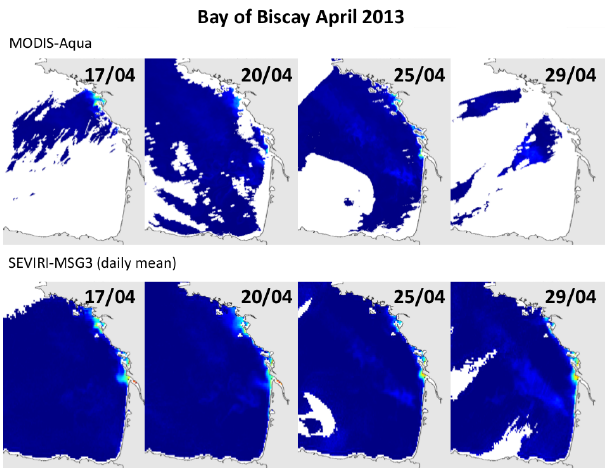
Figure 1. Sequence of daily observations of the Bay of Biscay by NASA’s polar-orbiting MODIS sensor on the Aqua platform and by SEVIRI on MSG3. Development of coccolithophore blooms can be clearly followed on the SEVIRI daily mean images of the red marine remote sensing reflectance. The figure is reproduced from Vanhellemont et al.